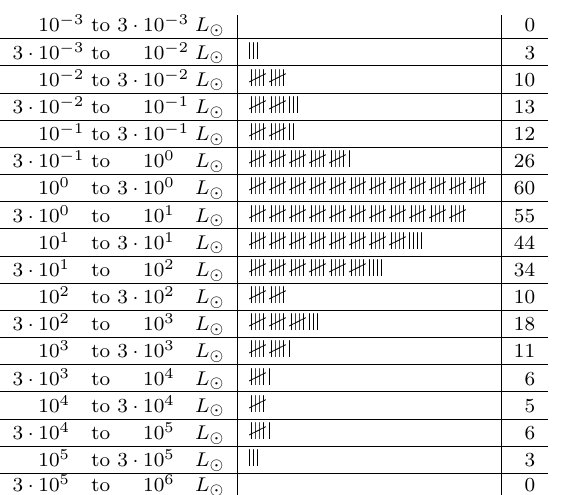
Fig. 24.— Tally sheet in preparation for a hand-crafted histogram